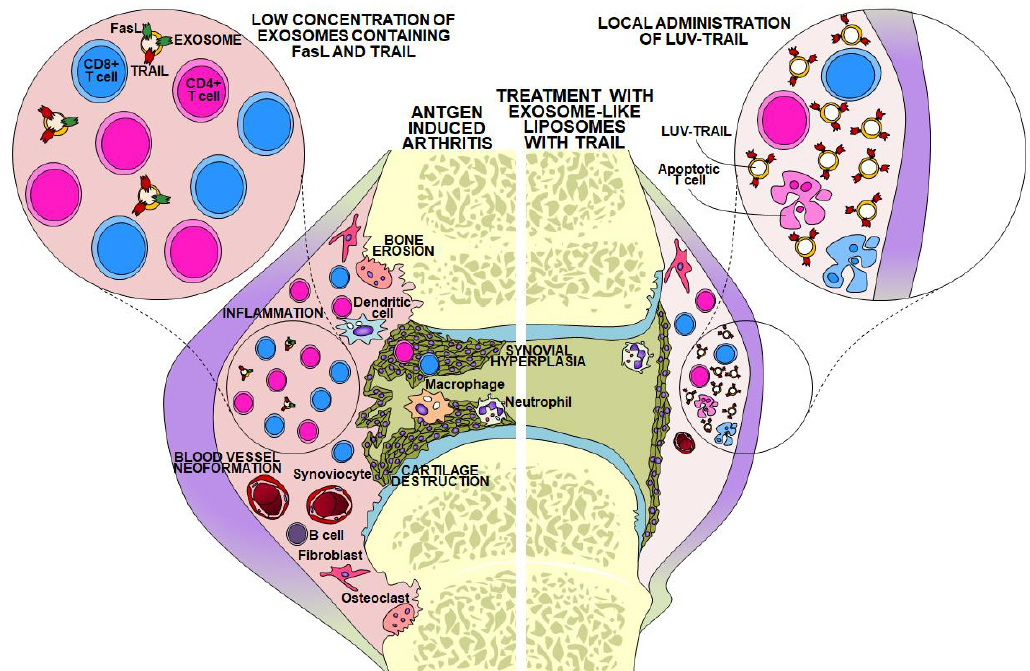
Figure 2. Left , schematic description of the situation in an arthritic lesion with the prototypical pathologic hallmarks: inflammatory infiltrate, blood vessel neo-formation, synovial hyperplasia, and, as a consequence, bone erosion and cartilage destruction. This situation is associated with a low concentration of regulatory FasL and/or TRAIL-containing exosomes, probably favoring T cell chronic infiltration. Right , situation upon intra-articular delivery of large unilamellar vesicles decorated with recombinant TRAIL (LUV-TRAIL), resulting in the elimination of synovial hyperplasia and in a reduction of the inflammatory infiltrate (based on data in references